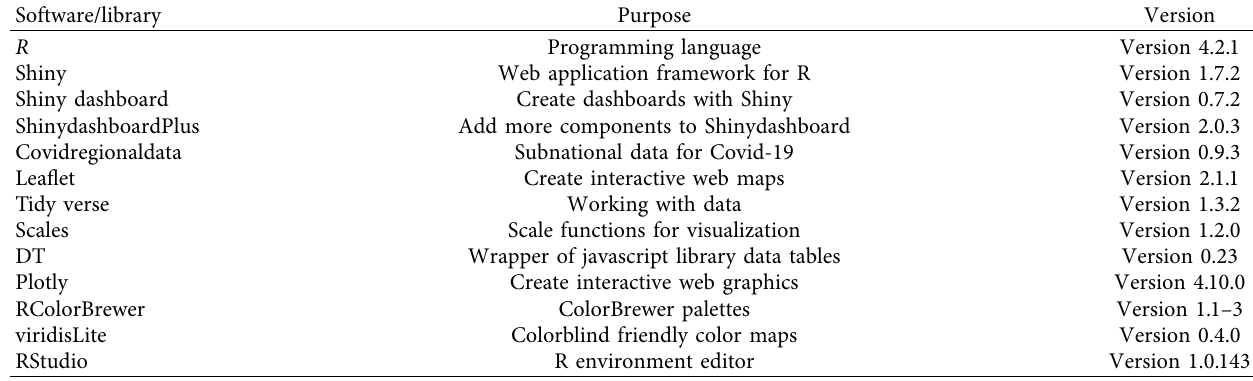
Table 1: Software